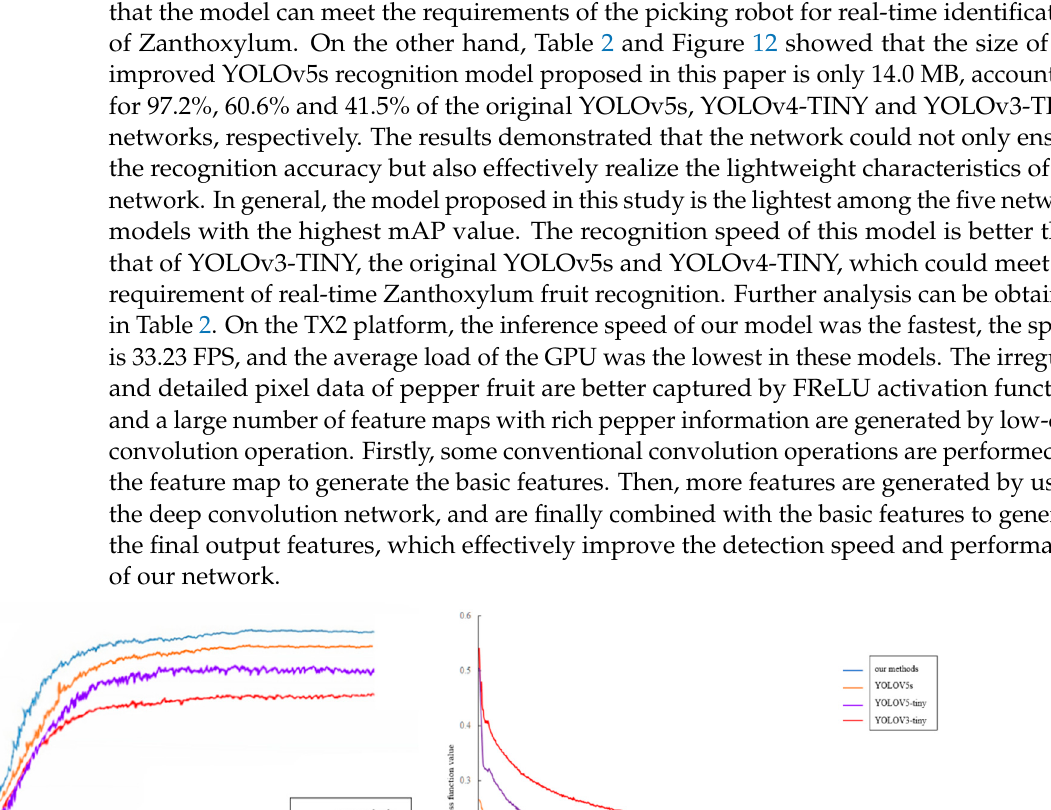
Table 2. Comparison of different detection models in the Zanthoxylum pepper dataset.